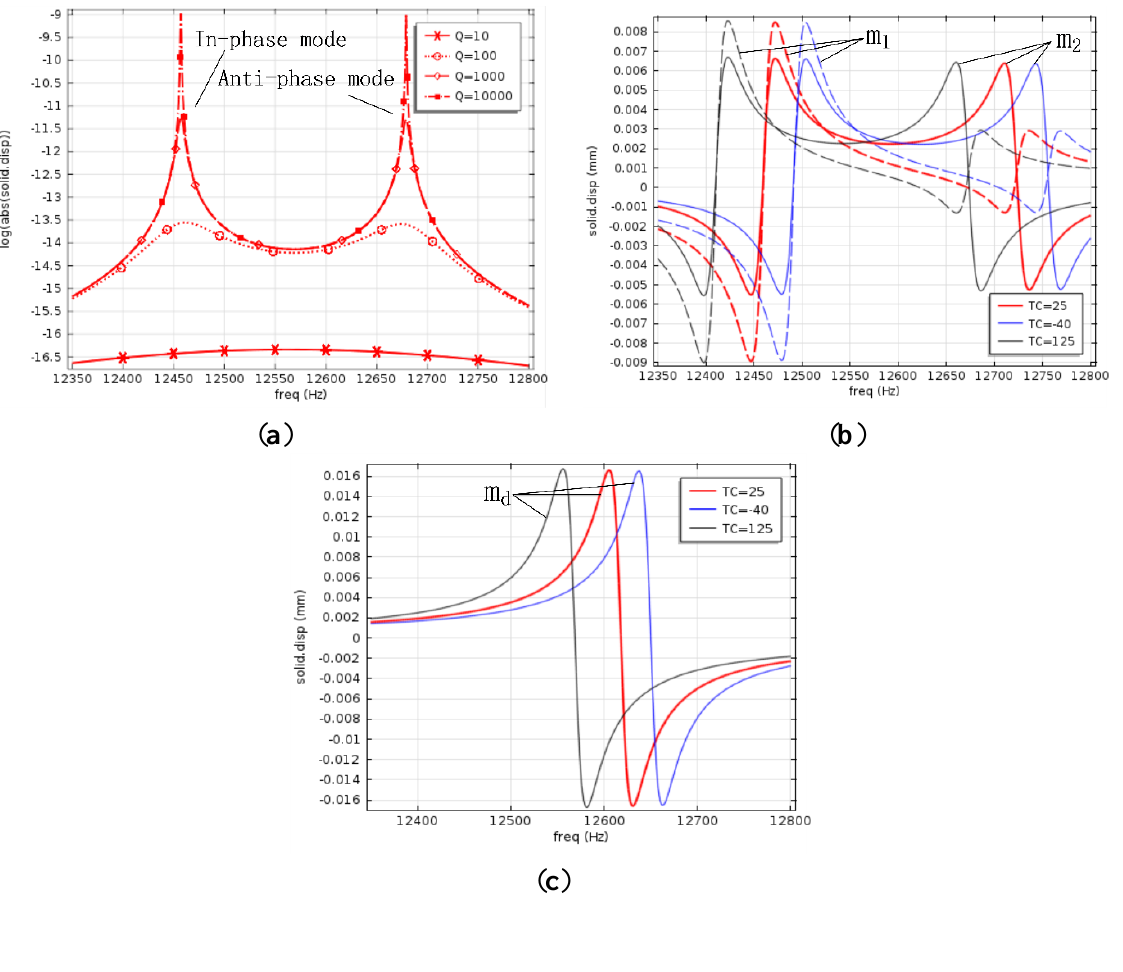
Figure 6. Simulated frequency response of the designed MEMS gyroscope. ( a ) Frequency response of m against damping factors at room temperature; ( b ) The sense mode 2 frequency response against temperature variations; ( c ) The drive mode frequency response of against temperature